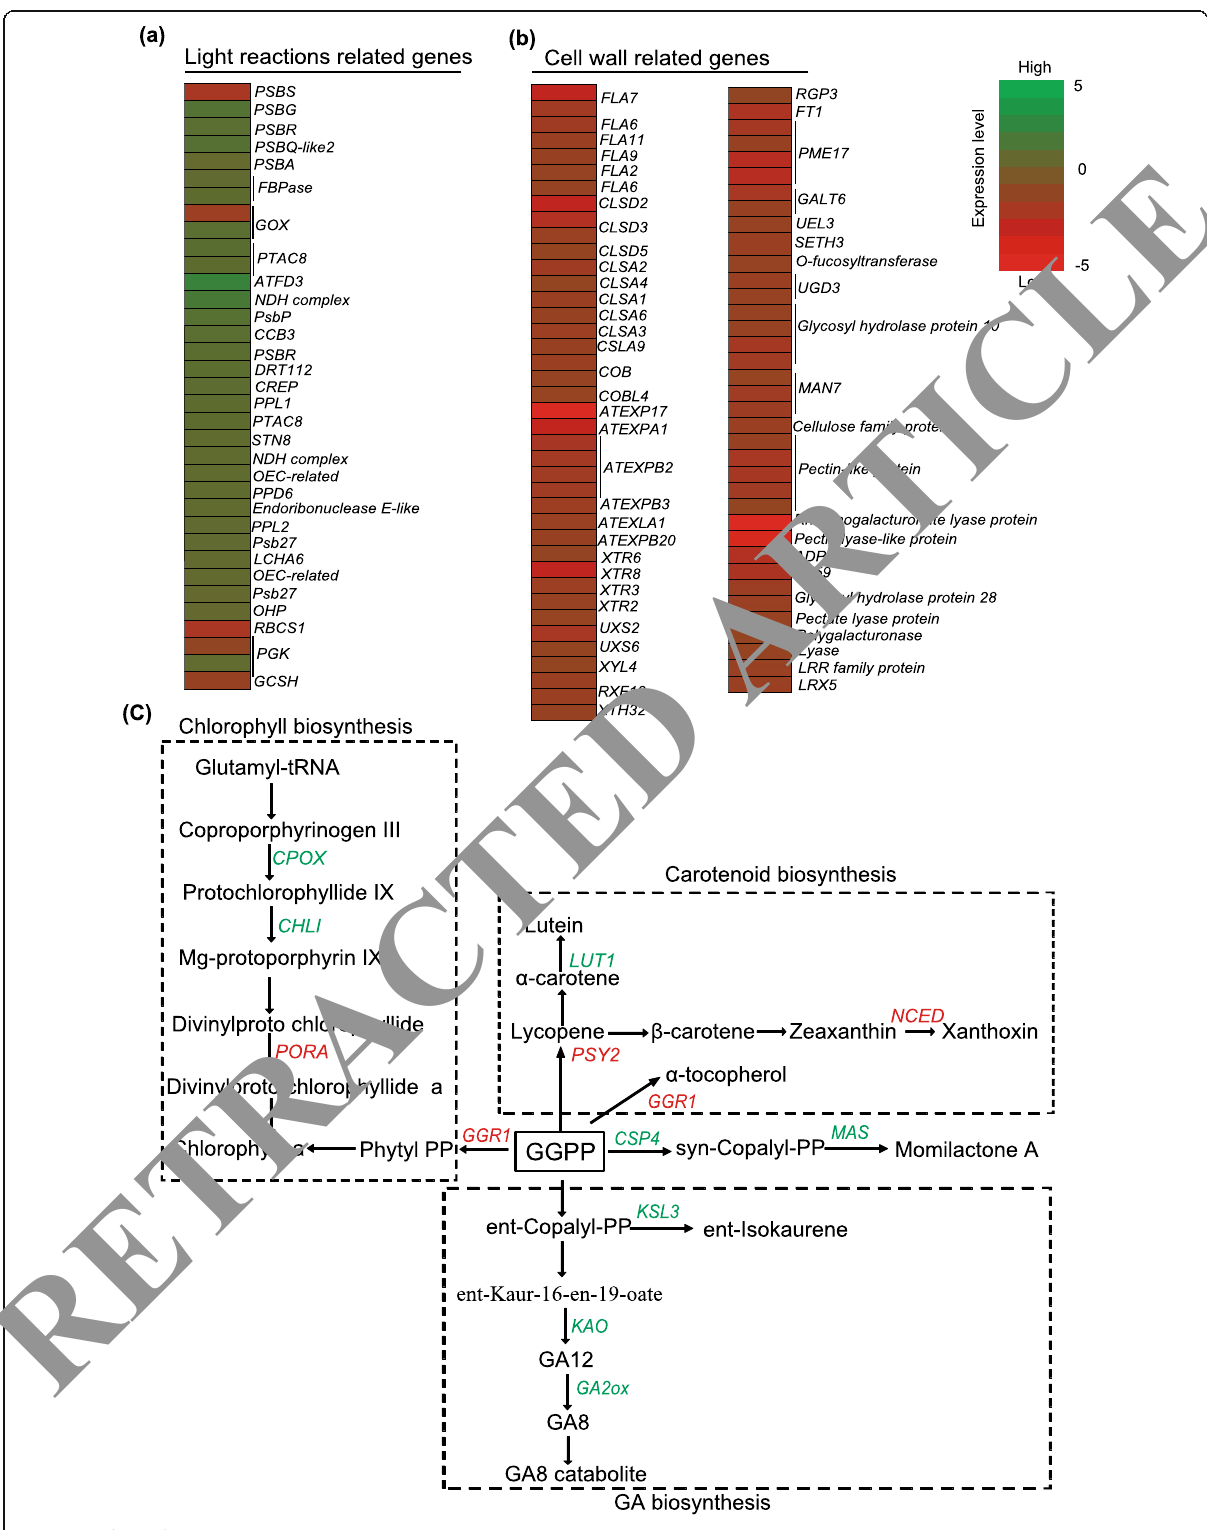
Fig. 3 (See legend on next